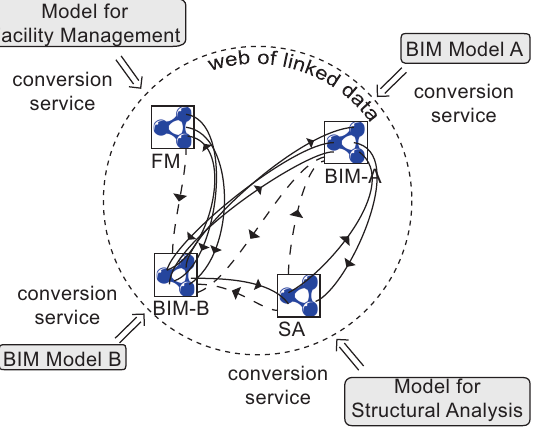
Figure 12. Diverse conversion services might enable to make diverse partial information models (BIM Model A, Model for Facility Management; BIM Model B, Model for Structural Analysis) available in Resource Description Framework (RDF) graphs. The conversion steps are indicated in the figure as arrows going in one direction from the native format (outer circle) towards the RDF graph format (icons in inner circle). The resulting graphs might then be linked in a “web of linked data” using semantic web technologies (dashed and full arrowed